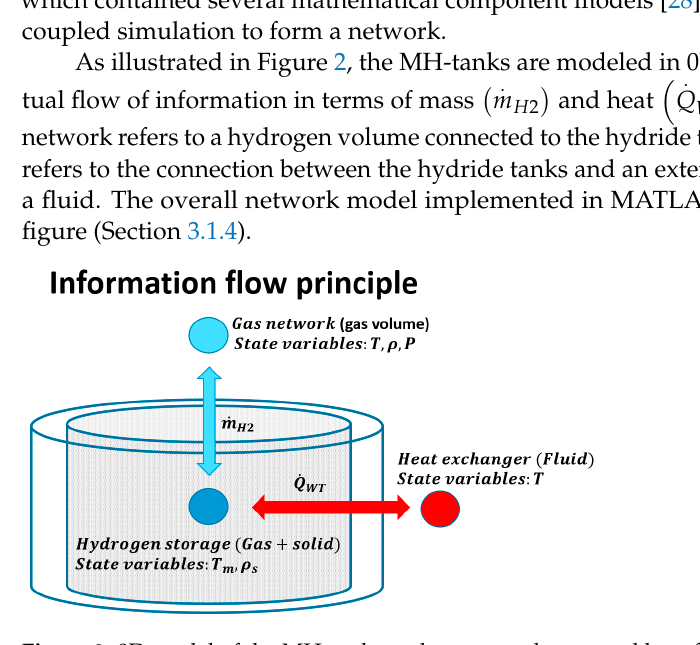
Figure 2. 0D model of the MH-tanks and conceptual mass and heat flow connections.